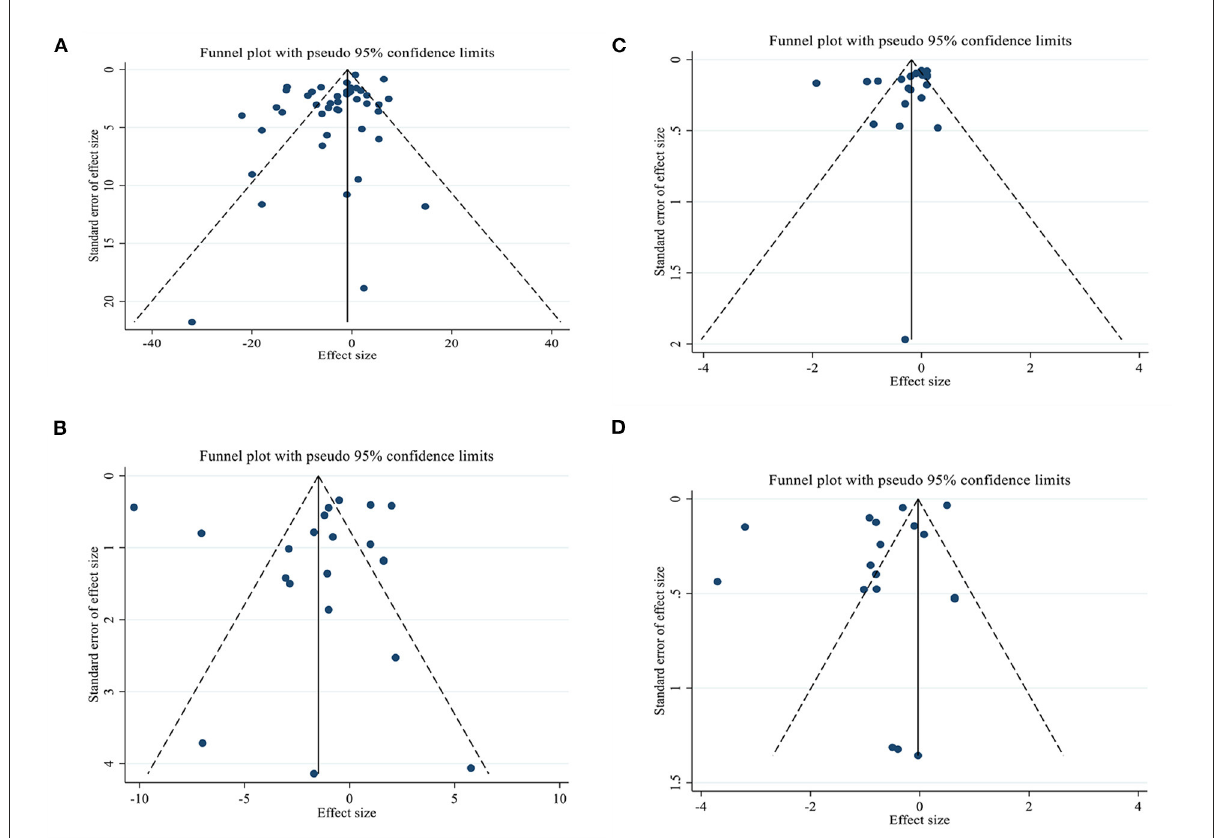
FIGURE3 Funnel plots for the effect of L-carnitine consumption on (A) FBG (mg/dl); (B) Insulin (pmol/l); (C) HbA1c (%); (D) HOMA-IR. FBG, fasting blood glucose; HOMA-IR, homeostasis model assessment for insulin resistance; HbA1C, hemoglobin